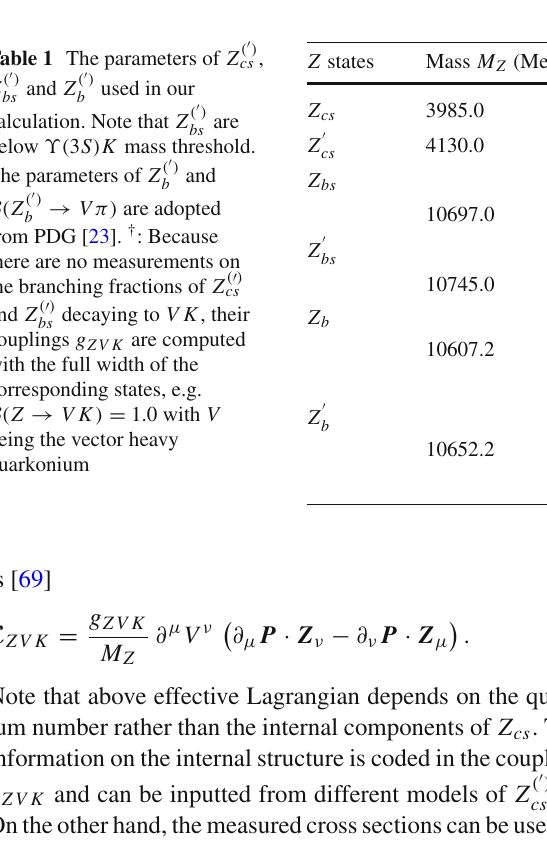
Fig. 3 The diagrams of γ p → V K (cid:3) reaction. a The Z ( duction in γ p → J /ψ K (cid:3) reaction with Z nels. b , c Background contribution through Pomeron exchange. Similar